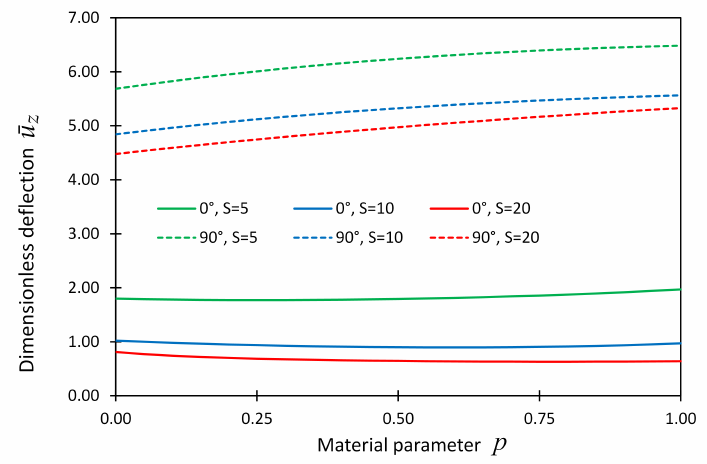
Figure 8. The dimensionless displacement, ¯ u z , at locations ( x , y , z )=( L x /2, L y /2, L z /2) versus material parameter p for Example 2 considering boundary conditions CCCC.